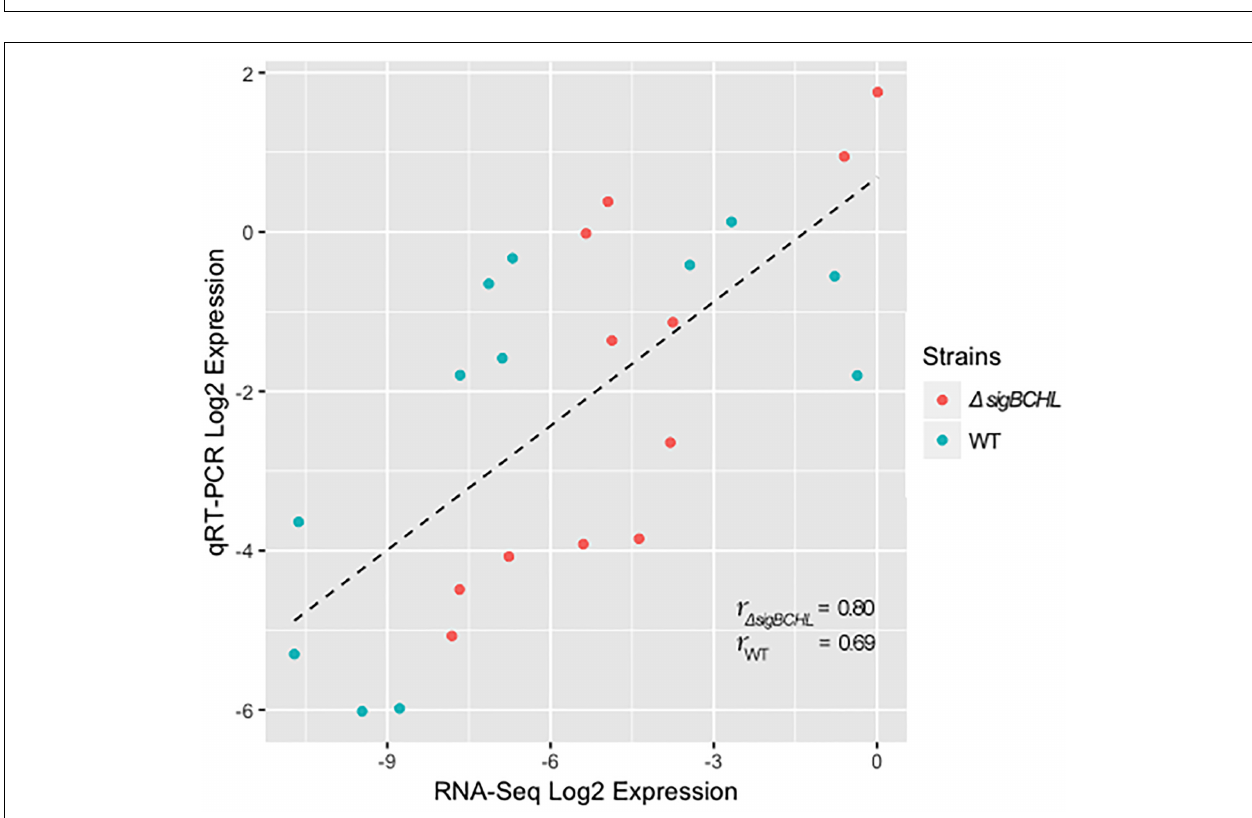
FIGURE 3 | Confirmation of DEGs by TaqMan qPCR. Transcript levels were quantified in up-regulated sets of genes i.e., Group I ( LMRG_01669 , LMRG_02283 , and plcA ), Group II ( LMRG_01149 ), and Group III ( LMRG_00091 ) and in down-regulated gene ( gadT2 ). Wild type transcript levels are in gray and (cid:49) sigBCHL transcript levels are in black. Transcript levels are expressed relative to WT after normalization to geometric mean of housekeeping genes, rpoB and bglA ( Supplementary Table S7 ). Experiments were performed in biological triplicates. Asterisk indicates significance fold difference relative to wild type.